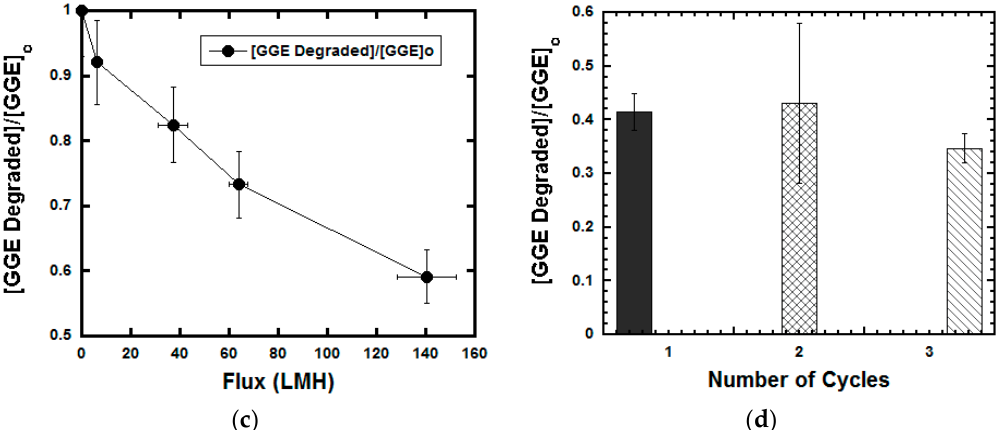
Figure 5. Degradation of GGE ( a ) by the multienzyme-functionalized membrane, ( b ) as a function of residence time, ( c ) by the laccase-functionalized membrane as a function of flow rate and ( d ) by the activity of the multienzyme-functionalized membrane towards GGE degradation after multiple cycles. Experiments were performed at a temperature of 22 °C and a pH of 5.6. The initial substrate concentration was 3.1 mM GGE in water. LMH, L·m − 2 ·h − 1 .